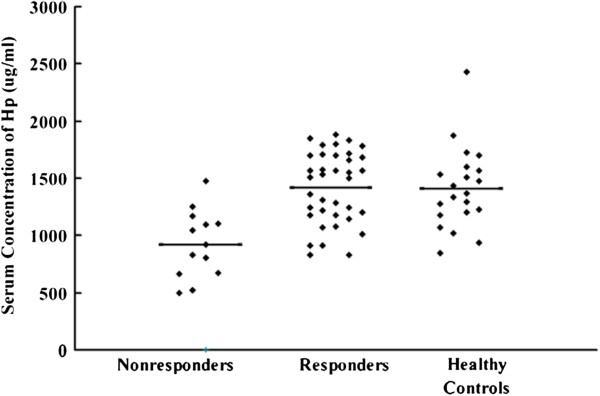
The preoperative serum level of Hp was validated by ELISA. One-way ANOVA analysis showed significant difference of preoperative serum Hp expressions among the three groups. The preoperative serum levels of Hp in thirteen nonresponders was significantly lower than that of thirty-seven responders (p <0.001) and twenty-one healthy controls (p <0.001). No significant difference was seen between the responders and healthy controls (p > 0.05).